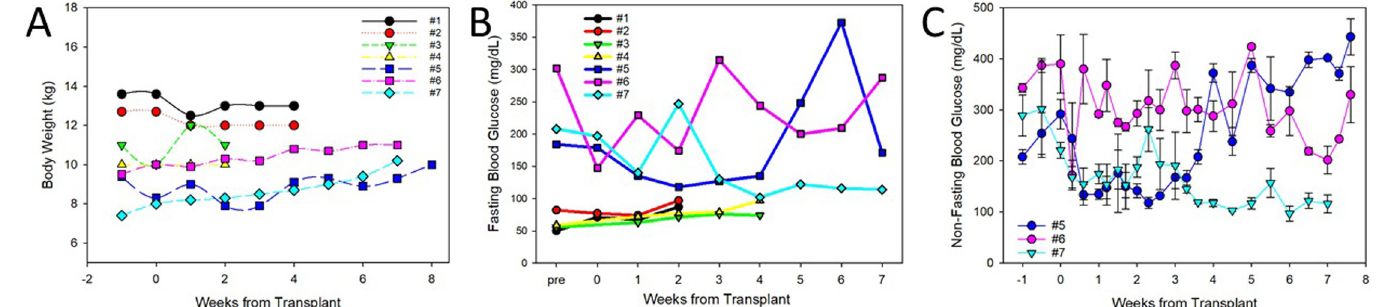
Fig 4. Body weight and blood glucose values. A) Body weight was obtained weekly showing little change over the course of the two studies. B) Fasting blood glucose was monitored weekly in the animals. Dogs #1–4 showed no change in blood glucose. Dog #5 had the lowest total dose of islets among the diabetic dogs that were administered in 2 doses; the first on day 0 and the second 2 weeks later. He had a temporary return to blood glucose levels within the normal range. Dog #6 had a higher dose, but administered at one time. This dog had little response to the transplant. Dog #7 had the highest dose again administered in 2 rounds and showed a full response with no further requirement for exogenous insulin. C) More detail in the daily fluctuations of the non-fasting blood glucose levels is provided for the 3 diabetic